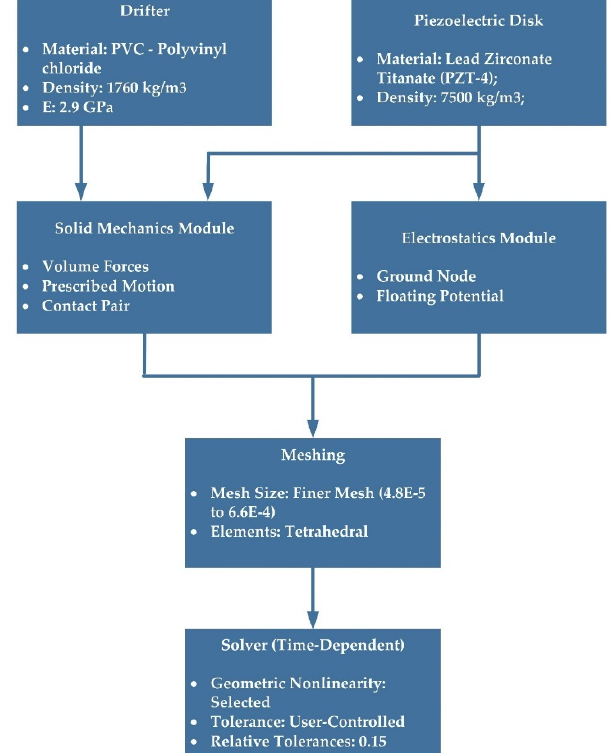
Figure 7. Flowchart of the FEA simulation in COMSOL.